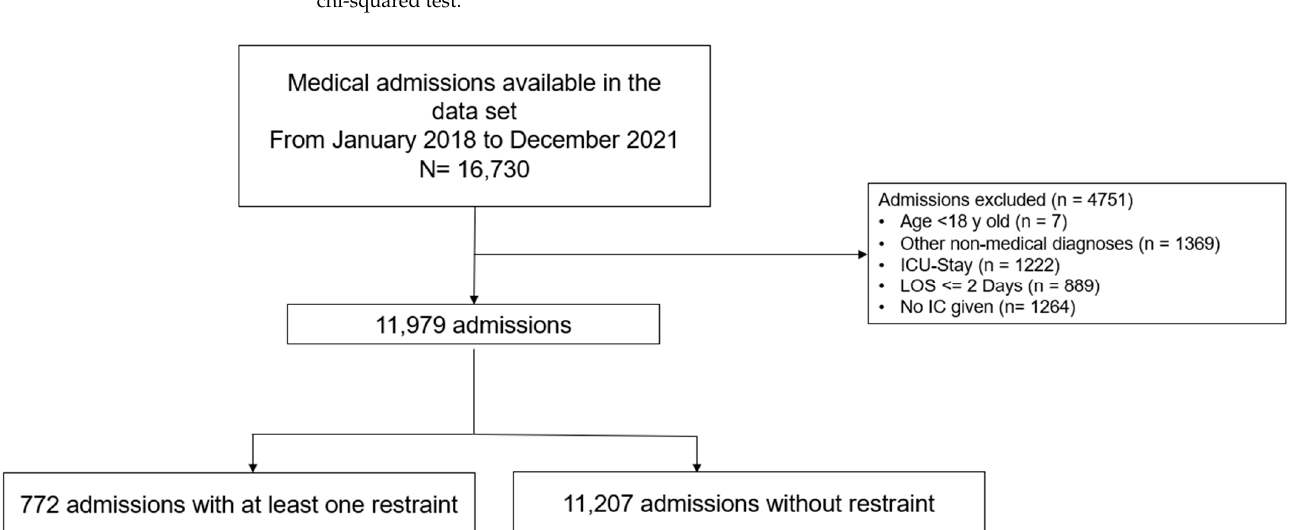
Figure 1. Flow chart of patient selection process. Abbreviation: LOS, length of stay; IC, informed consent; ICU, intensive care unit.